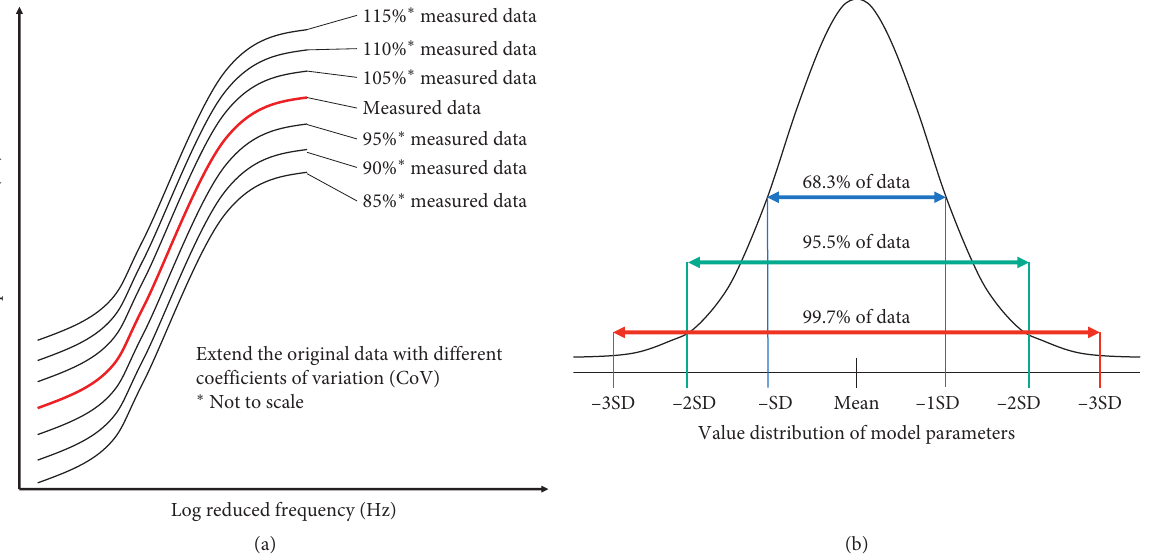
Figure 2: Qualify the data variation and modeling uncertainty quantitatively. (a) Data variation. (b) Modeling